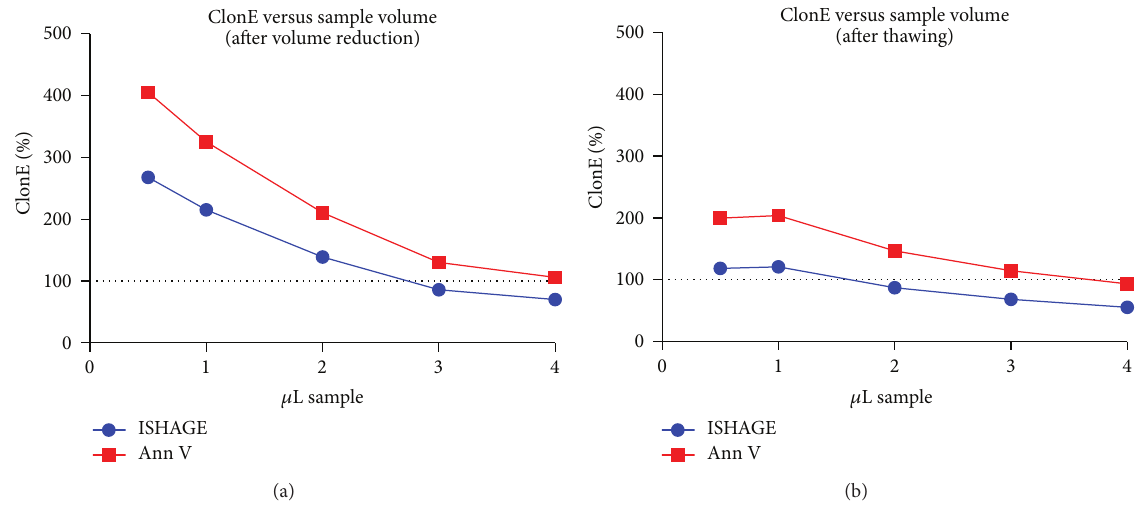
Figure 4: The relation between the concentrations of CD3 4 + cells and the resulting colonies. Seeding low volumes, the clonal efficiency ClonE was as high as 400% or 200% after volume reduction (a) and after thawing (b), respectively. At higher volumes, by representing a higher CD34-seeding density, the results approached boundary limits of nearly 100% (Annexin V) or less